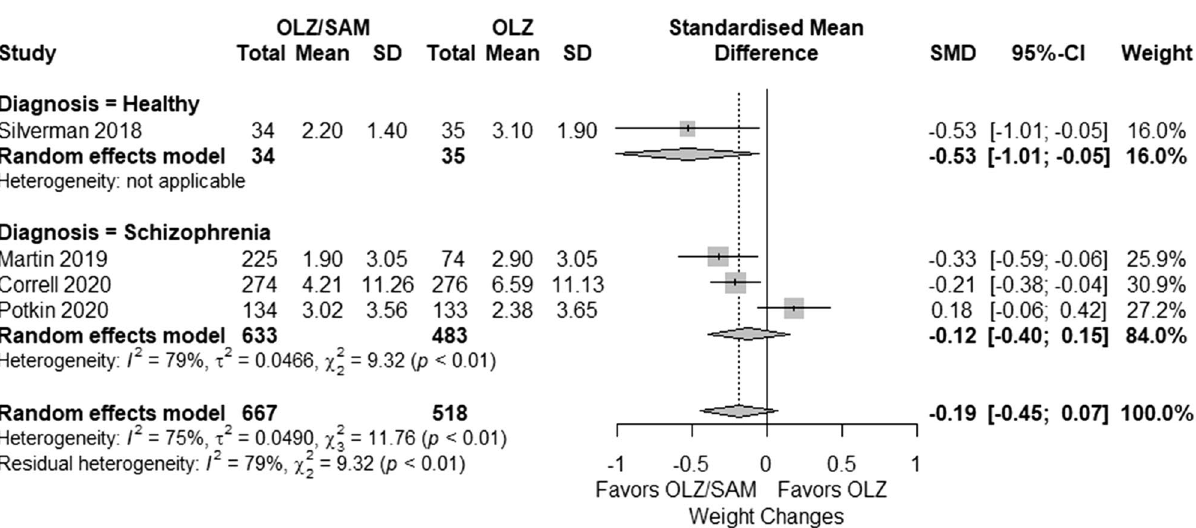
Figure 3. Subgroup meta-analysis (healthy individuals vs. patients with schizophrenia) of weight changes expressed as the standardized mean differences comparing between olanzapine/samidorphan and olanzapine. The upper two diamonds indicate the pooled results of healthy and schizophrenia subgroups, respectively. The diamond at the bottom shows the pooled results of all